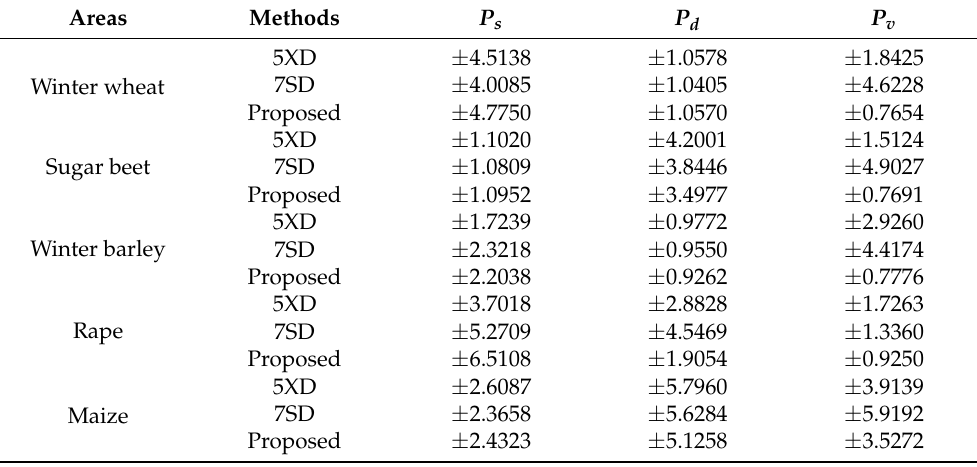
Table 8. The standard deviations corresponding to different scattering contributions (dB) estimated by three decomposition schemes